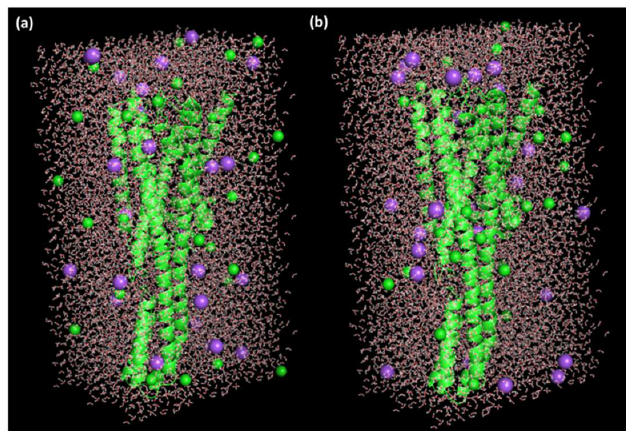
Figure 2. A triclinic box of ( a ) TZD drug alone and ( b ) [(TZD)(DCQ)]. In the NPT/NVT equilibration run, both systems were subjected to periodic bound- ary requirements using a Leap-frog MD integrator at constant temperatures of 300 K and pressures of 1.0 bar for a maximum time of 100 ns [34]. Energy reduction utilizing the steepest descent approach with 5000 steps was carried out [35] to reduce poor contact inside the system. Trajectory analysis was carried out using GROMACS analytical meth- ods [36]. The root mean square deviation (RMSD) was calculated using the gmx rms tools and hydrogen bondings were investigated using the gmx hbond tool. The plots were com- pleted by Grace Software [37,38].